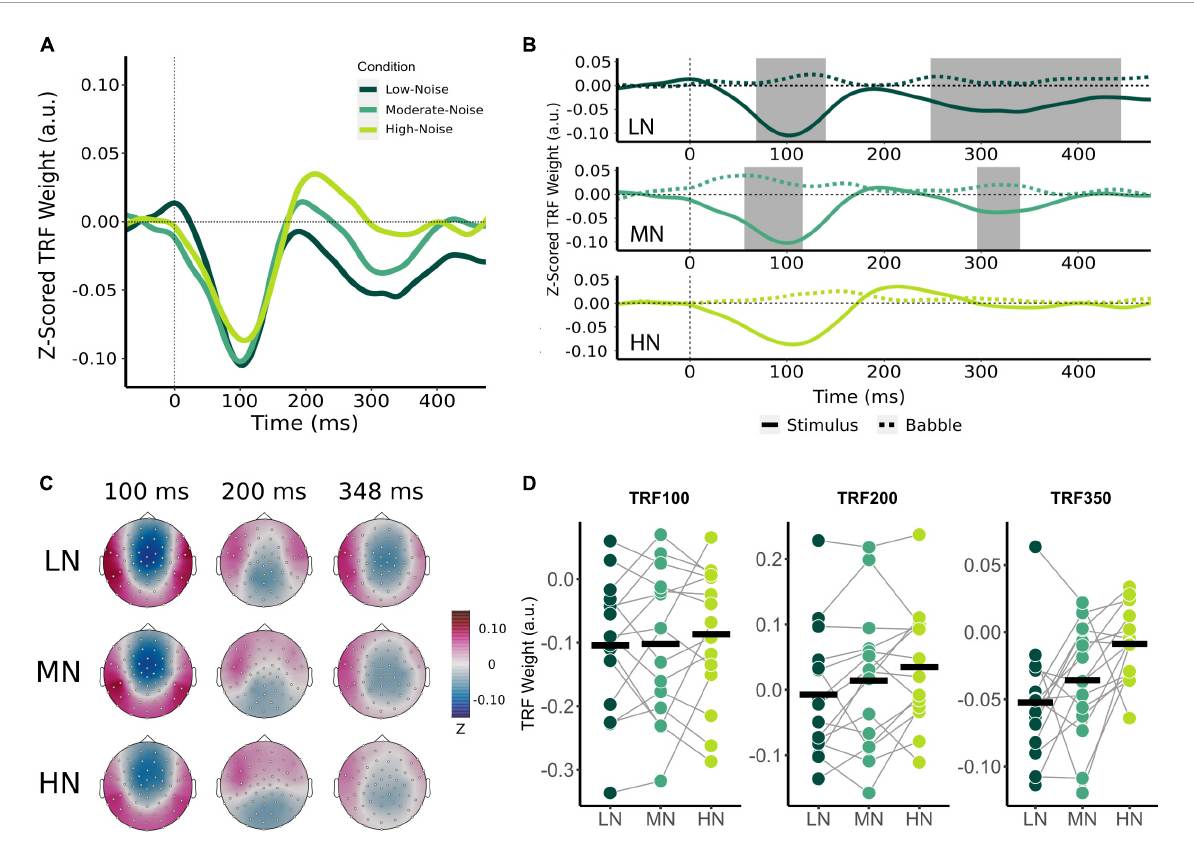
FIGURE3 Effect of increasing background noise on sensor-level TRF peaks. (A) Mean condition TRFs compared between the audiovisual Low-Noise (LN), Moderate-Noise (MN), and High-Noise (HN) conditions. (B) Mean stimuli (solid-line) and background noise (dotted-line) TRFs are compared for each condition (LN—top; MN—middle; HN—bottom) using paired t -tests. Shaded regions indicate time intervals where the TRFs were significantly different after correcting for multiple comparisons. (C) Topographies of the mean condition stimuli TRFs at the 100, 200, and 350 ms time lags. (D) TRF peaks were compared between the LN, MN, and HN conditions. Black horizontal bars indicate the mean TRF weight of each condition. No statistically significant differences between TRF amplitude averages were detected.